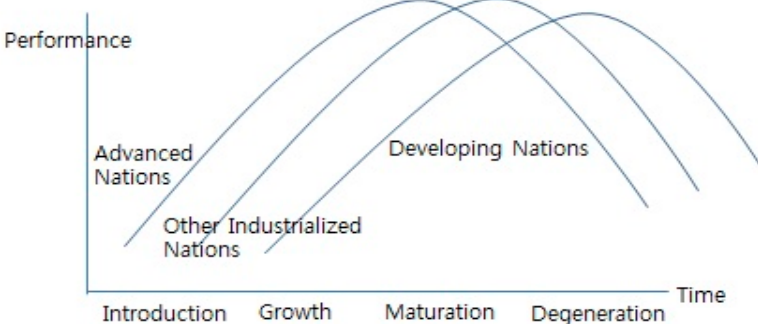
Figure 1. A typical technology life cycle model.